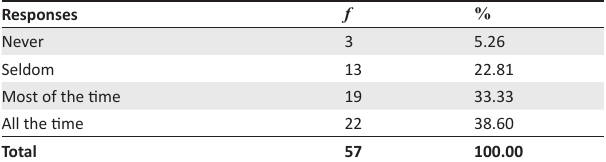
TABLE 9: Respondents’ views on how often shortages of staff occurred in their clinics ( n = 57).